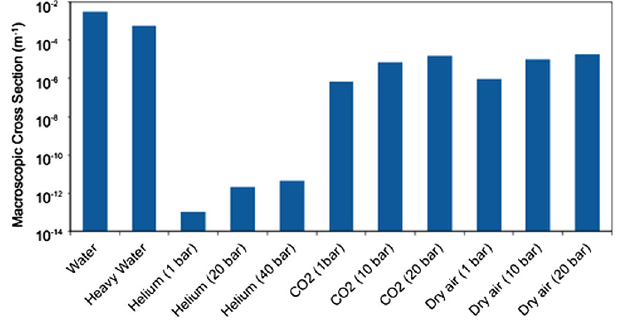
FIG. 3 (color online). Neutron absorption in different target coolants at different operating